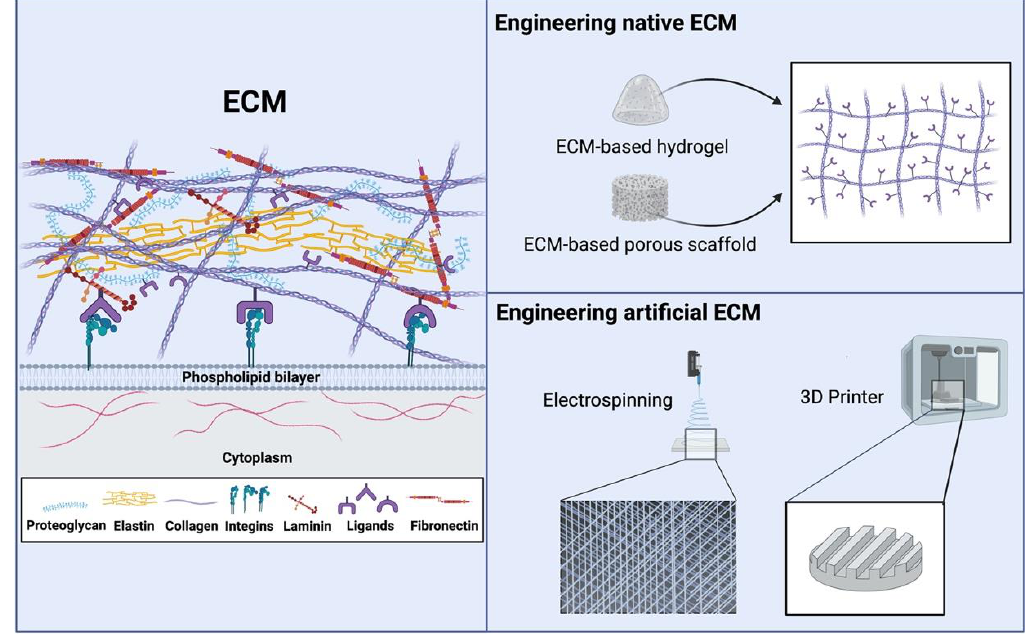
Figure 2. Engineering native ECM and artificial ECM.